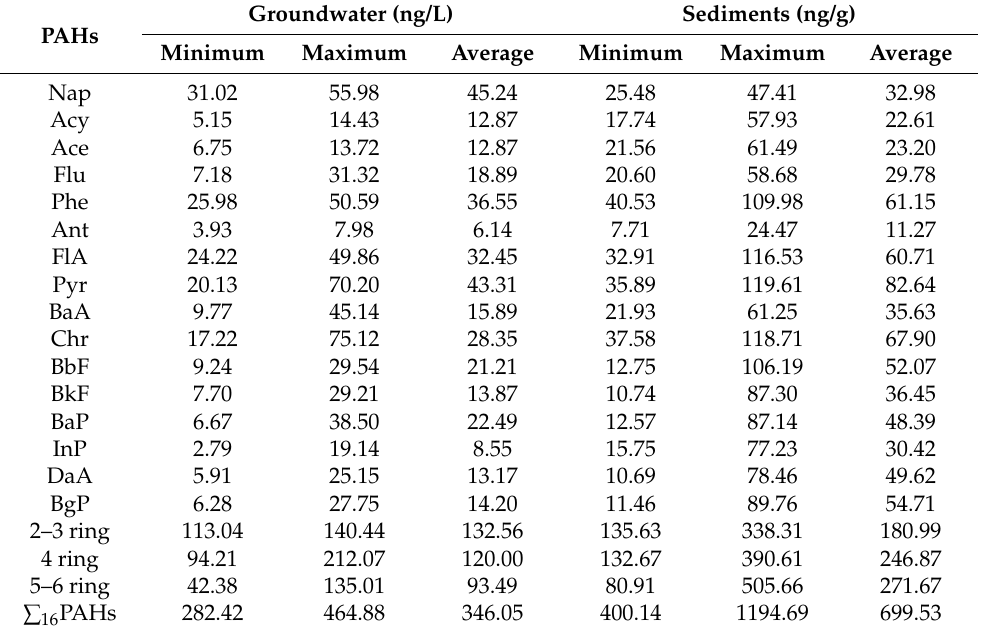
Table 2. Concentrations of ∑ 16 PAHs in the water environment of Qing-shui Spring under- ground